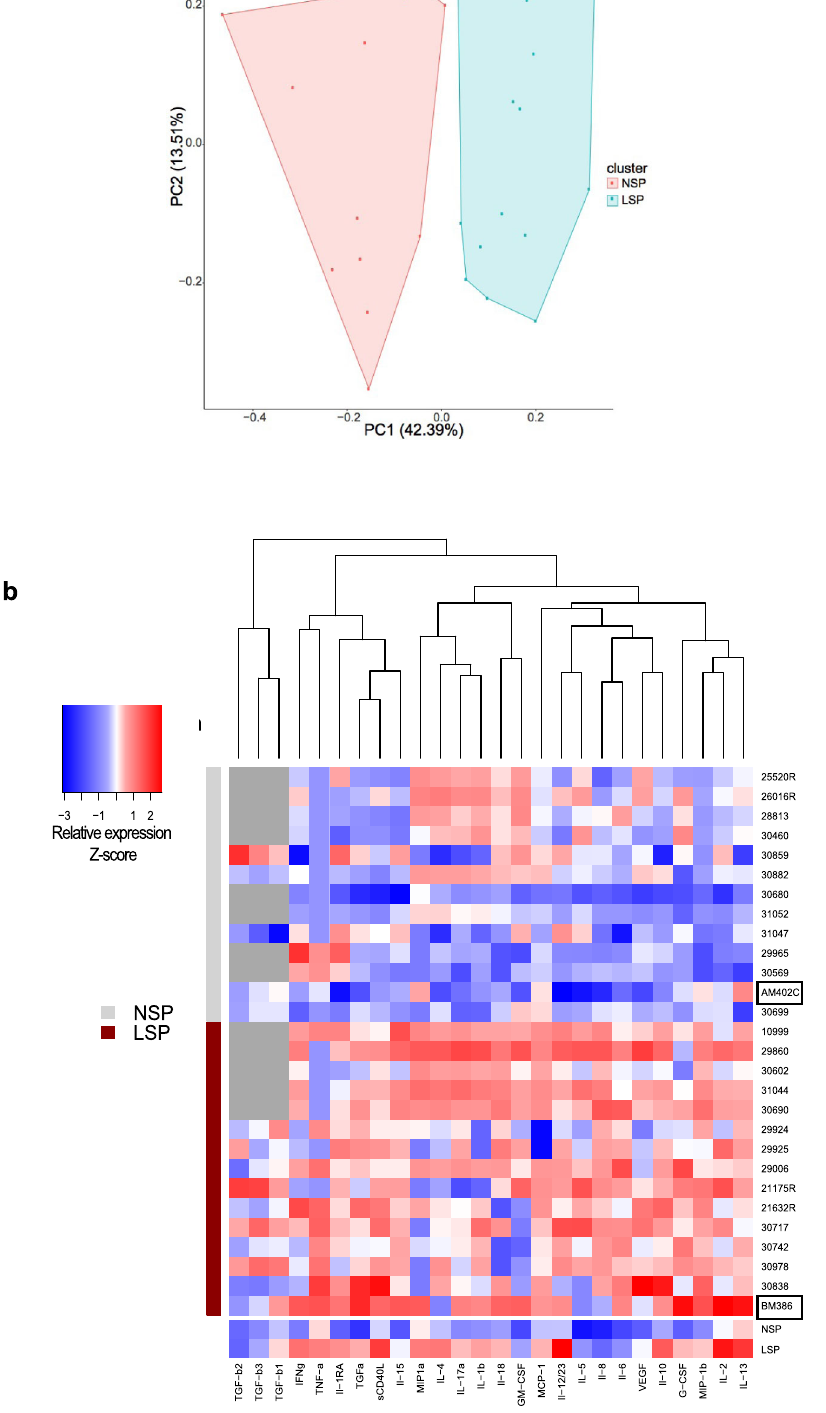
Fig. 2 In fl uence of leukocytospermia on cytokine levels in the seminal plasma of uninfected macaques. a Principal component analysis (PCA) showing that normal (NSP, pink dots) and leukocytospermic seminal plasma (LSP, blue dots) samples cluster separately. b Heatmap from Luminex data of 26 cytokines and chemokines in seminal plasma from 13 normal (NSP) and 15 leukocytospermic (LSP) uninfected macaques (with the exception of TGF-ß 1-2- 3, for which 5 NSP and 10 LSP were evaluated) and comparison with the seminal plasma pools (NSP and LSP) shown at the bottom of the heatmap. Boxed codes represent individual NSP and LSP used for ex vivo infection experiments. Data are shown as relative molecule concentration compared to the mean value. Upregulated molecules are shown in red and downregulated molecules in